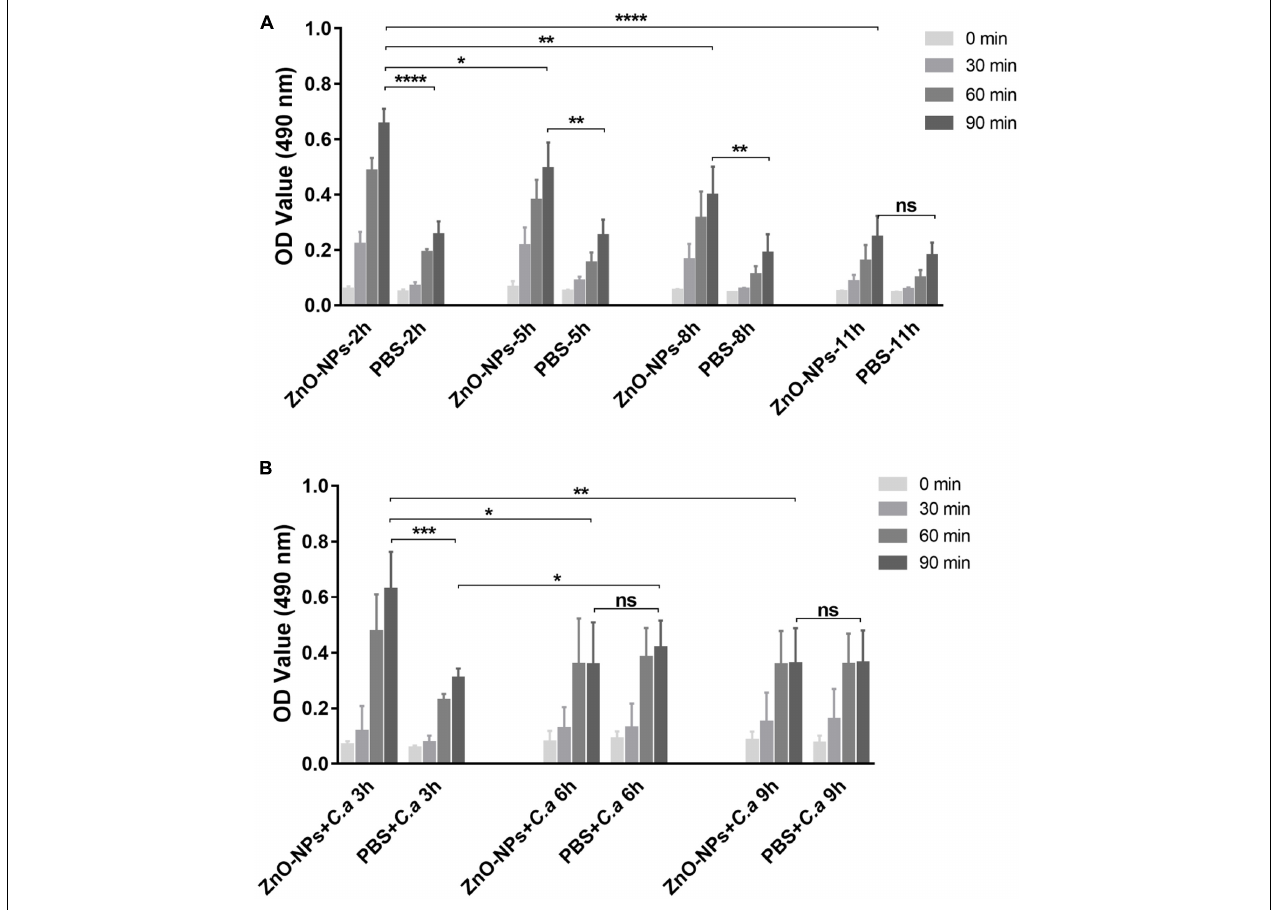
FIGURE 7 | Phenoloxidase (PO) activity in the hemolymph of ZnO-NP-pretreated G. mellonella with/without C. albicans challenge. (A) The PO activity in the hemolymph of ZnO-NP-treated G. mellonella at indicated time points after the inoculation. The same volume of PBS was injected as the control. (B) The PO activity in the hemolymph of G. mellonella receiving ZnO-NP pretreatment and C. albicans infection. Larvae 2 h post-ZnO-NPs or PBS treatment were immunized with C. albicans (1 × 10 5 CFU cells per larva) and used for detection of PO activity at 3, 6, and 9 h after challenge. The PO activity was determined using DOPA as a substrate based on melanin formation by measuring absorbance at 490 nm. The enzyme activity was quantified over 90 min at 15-min intervals presented as mean ± SD. The kinetics of the PO activity values were calculated from a representative experiment performed in triplicate. Difference analysis was assessed by using one-way analysis of variance (ANOVA) methods. * p < 0.05; ** p < 0.01; *** p < 0.001; **** p <